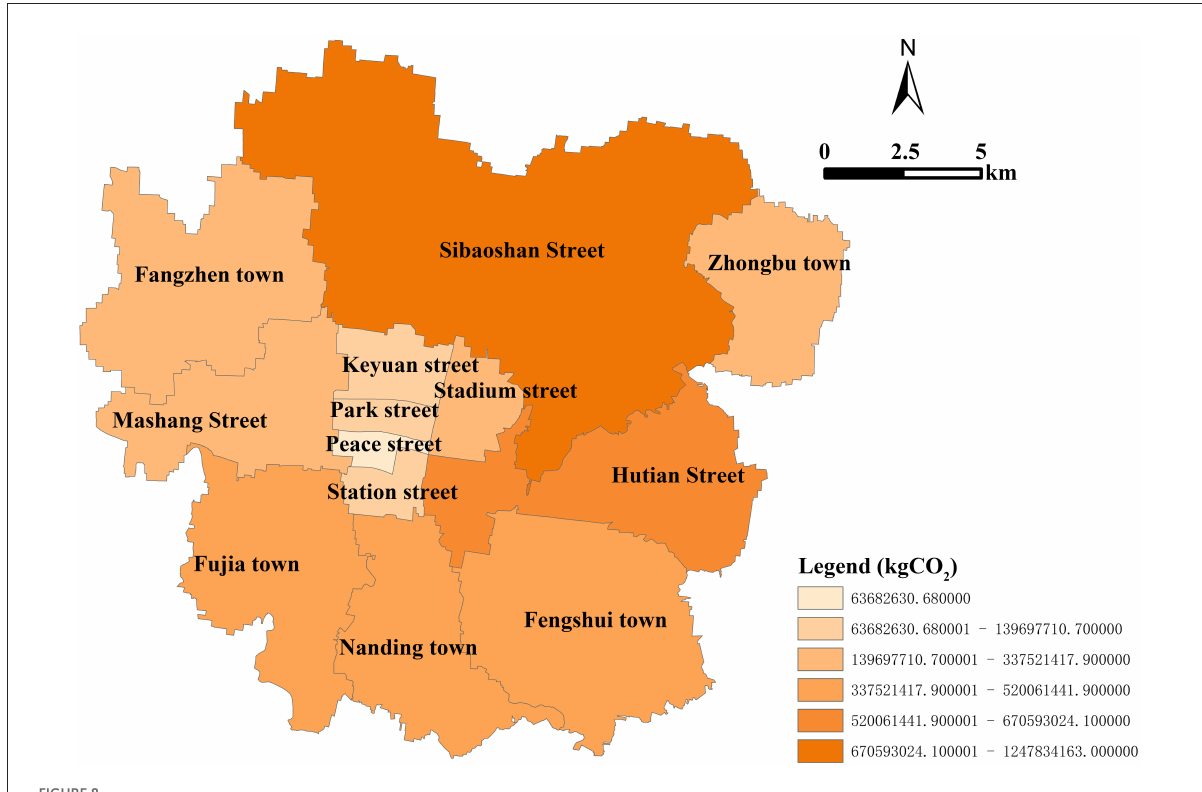
FIGURE8 Carbon emissions of subdistricts in